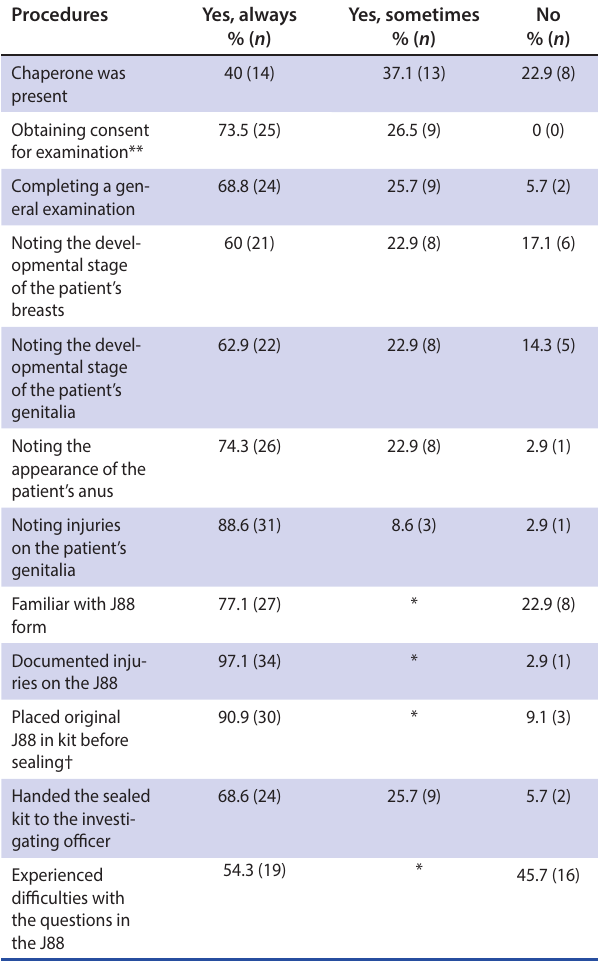
*Indicates that the option was not available for that particular question. ** n = 34. † n = 33.